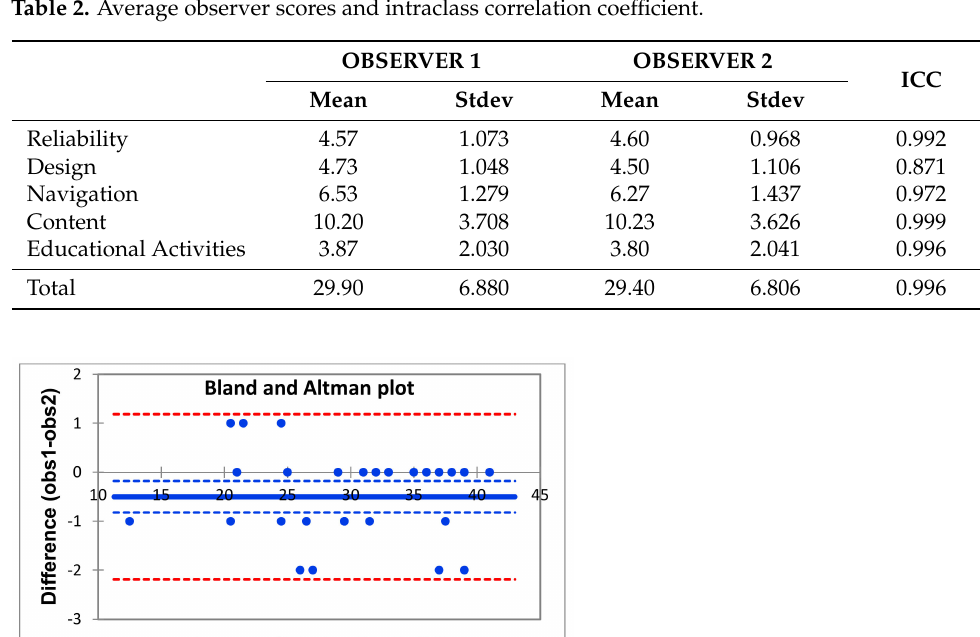
Figure 2. Inter-observer agreement scatterplot. Table 2. Average observer scores and intraclass correlation coefficient.